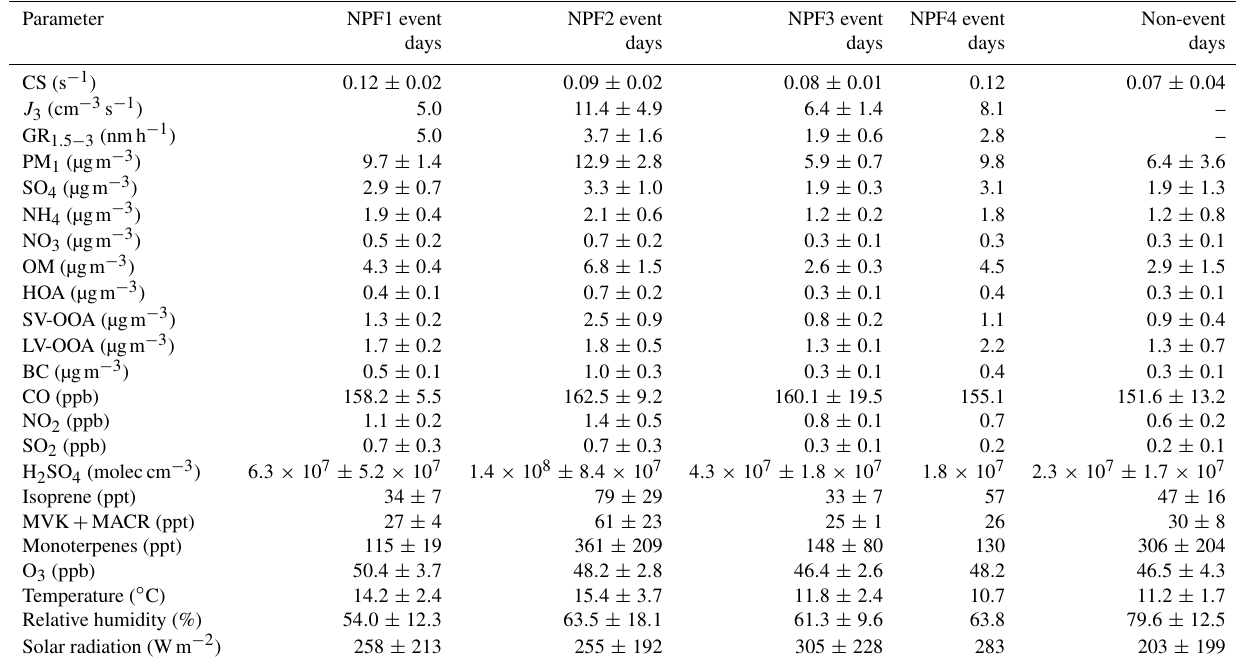
Table 2. Average and standard deviation of CS, particle formation and growth rates ( J 1 and GR 1 . 5 − 3 , respectively), meteorological parame- ters (temperature, relative humidity and solar radiation) and atmospheric parameter daily concentrations measured at the CAO station in the case of event (NPF1–NPF4) or non-event